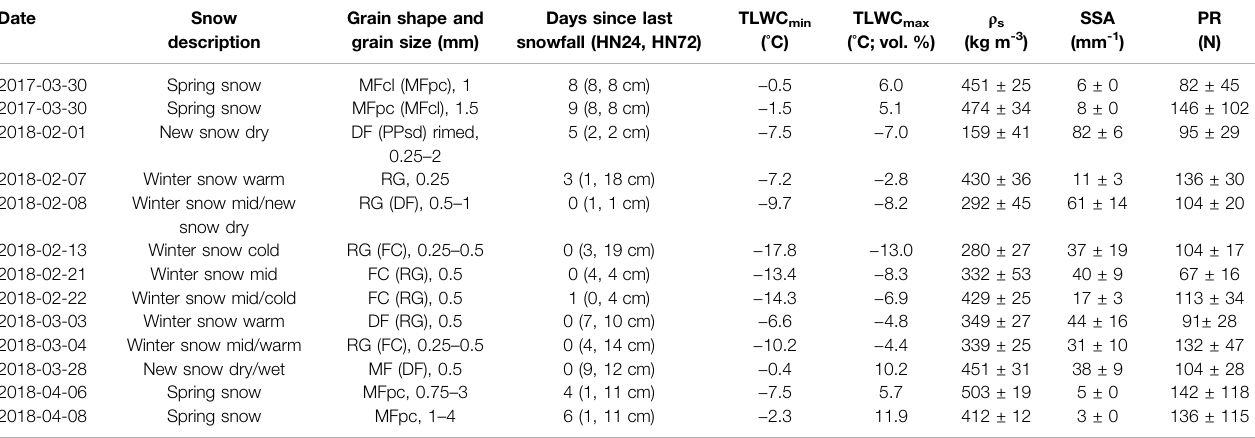
TABLE3| Snowconditionsoneachtestday:Colloquiallydescribed,classi fi edafterFierzetal.(2009),andquanti fi edbythedailyrange(TLWC)ormean( ± σ